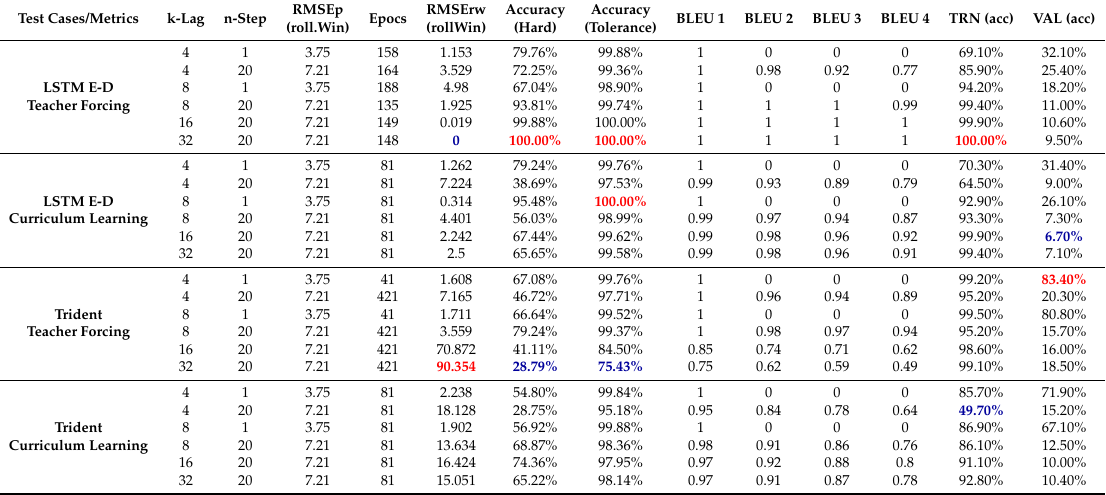
Table 3. Seq2Seq Encoder-Decoder Model In-Sample Training Data Set Performance Results. TestCases/Metrics